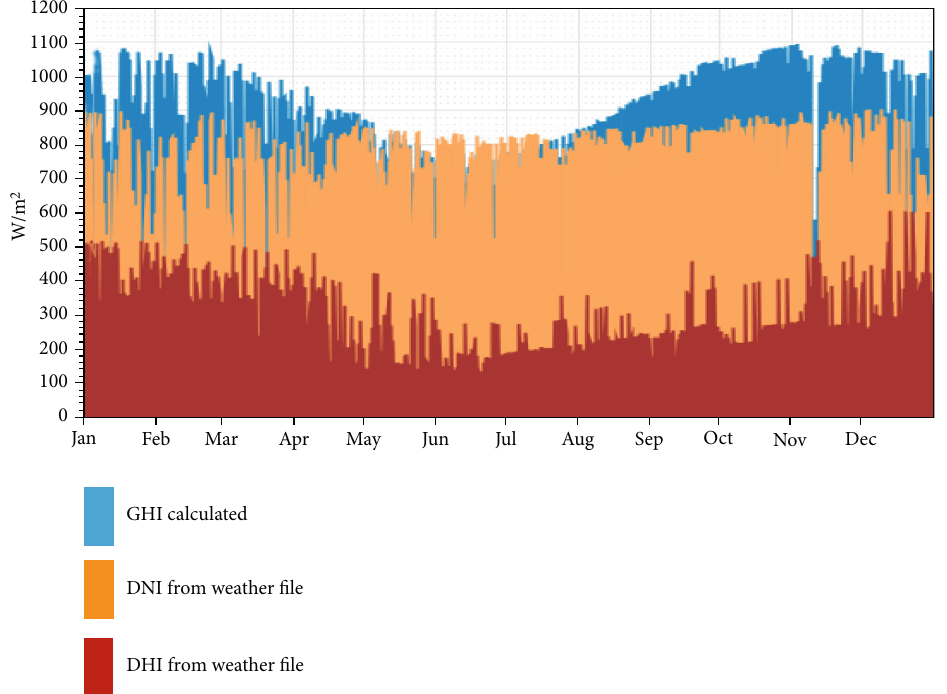
Figure 2: Monthly solar irradiance in